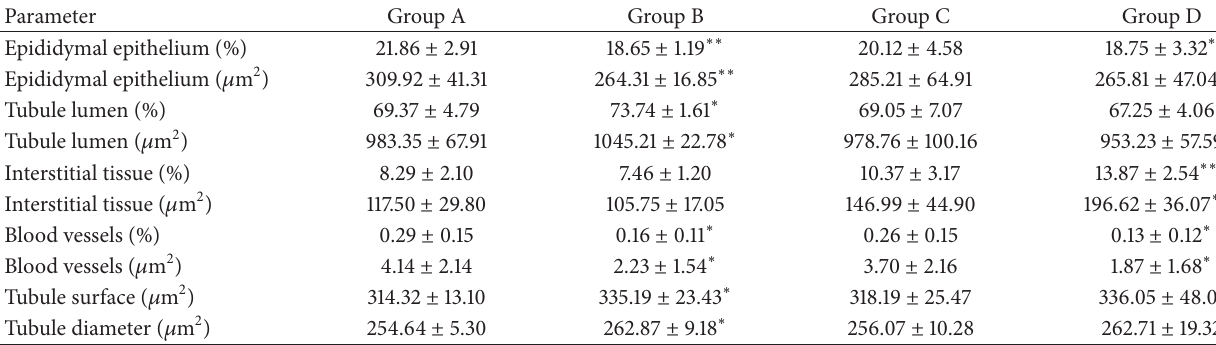
Table 3: Morphometric epididymal parameters.